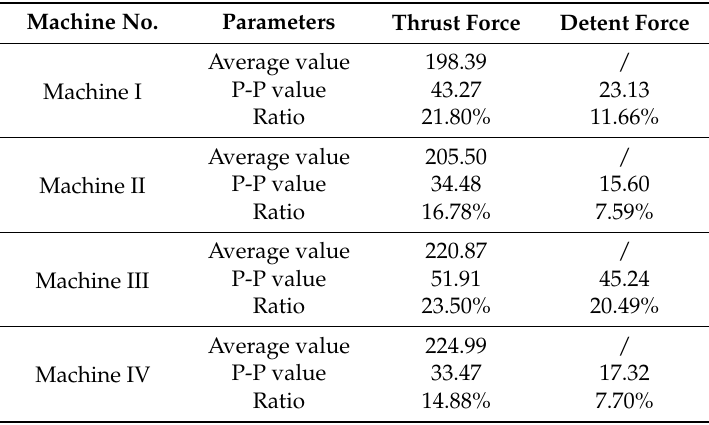
Table 4. Thrust force and detent force values (N).